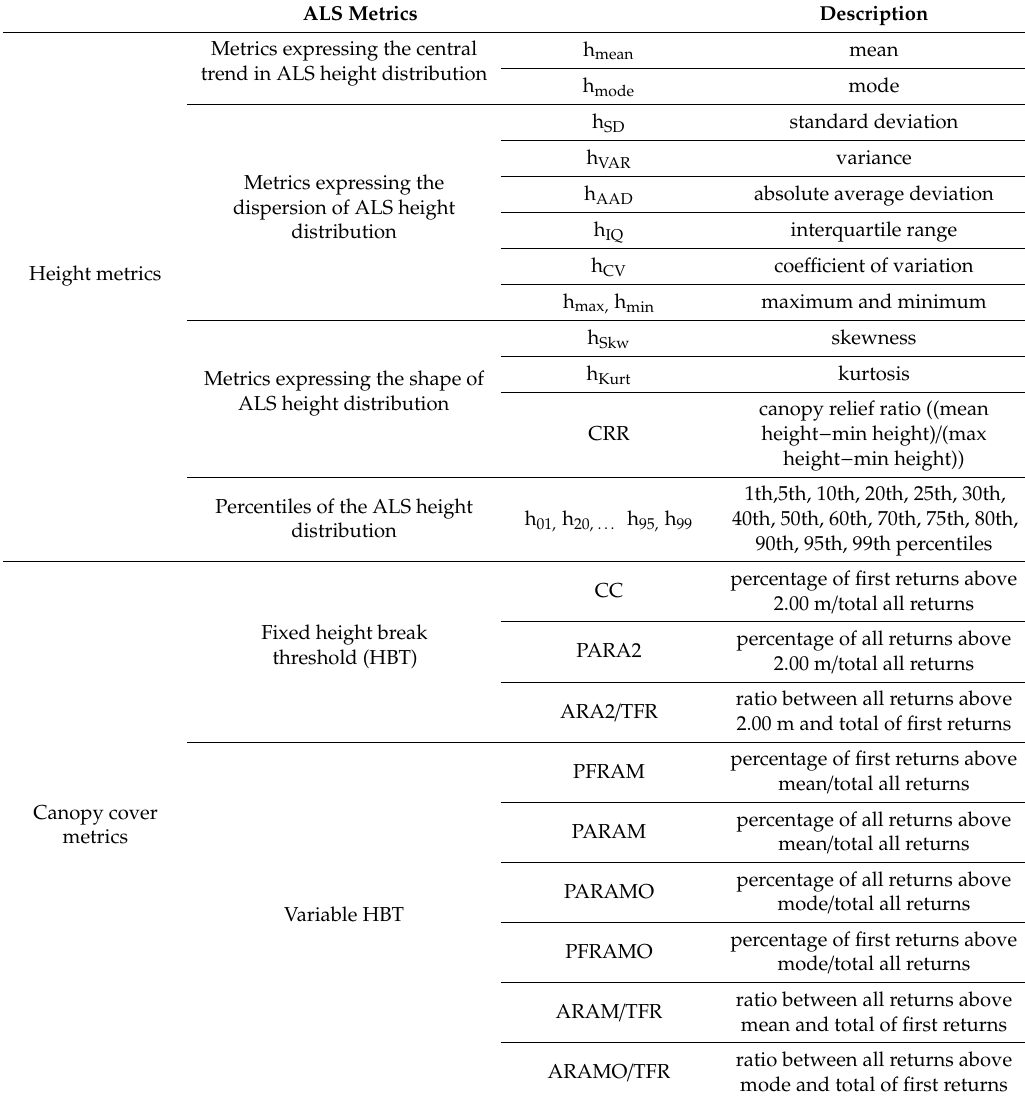
Table 2. Summary of Airborne Laser Scanning (ALS) metrics extracted for each